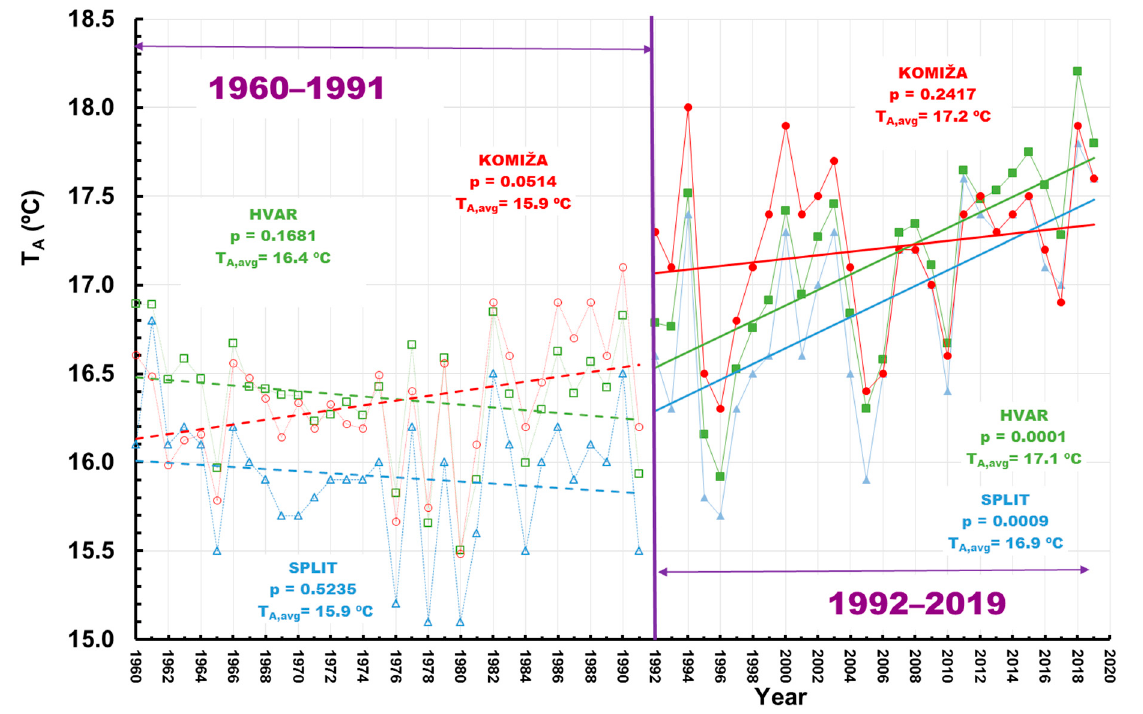
Figure 5. Time series of the mean annual air temperature measured at Split, Hvar, and Komiža stations. T A, avg is an average value of the mean annual air temperature, and p represents M–K test values, calculated for two sub–periods defined by the results of RAPS.